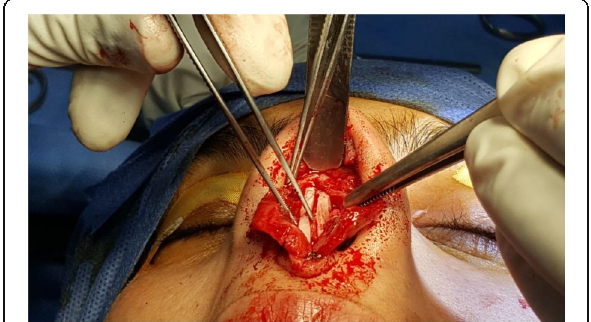
Fig. 1 Positioning of a bilateral spreader